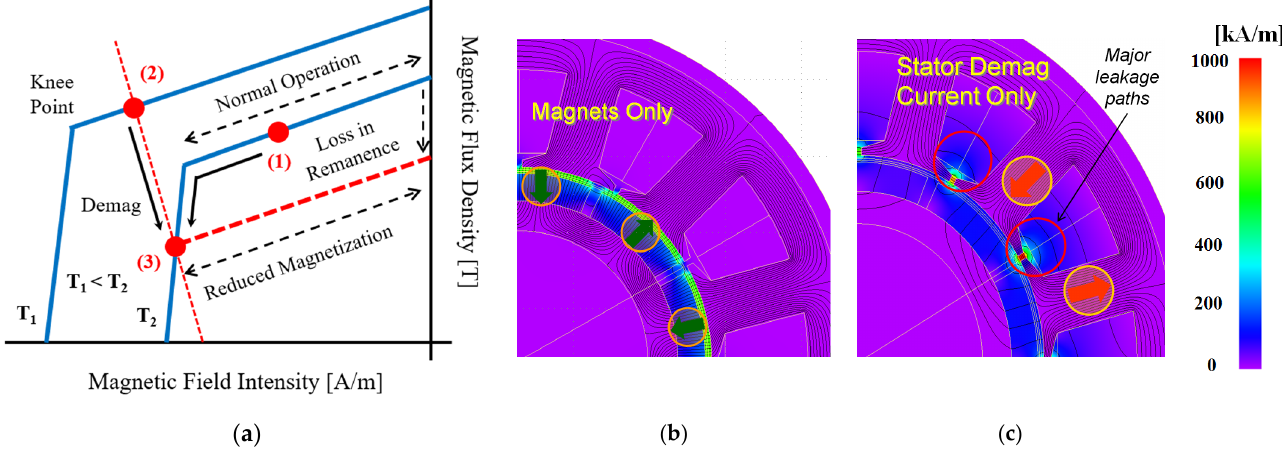
Figure 1. Magnet B–H curve characteristics and magnetic field strength H contours and flux lines for an SPM machine: ( a ) variation of magnet operating point on a B–H curve; ( b ) magnet flux alone; ( c ) demagnetizing MMF alone.